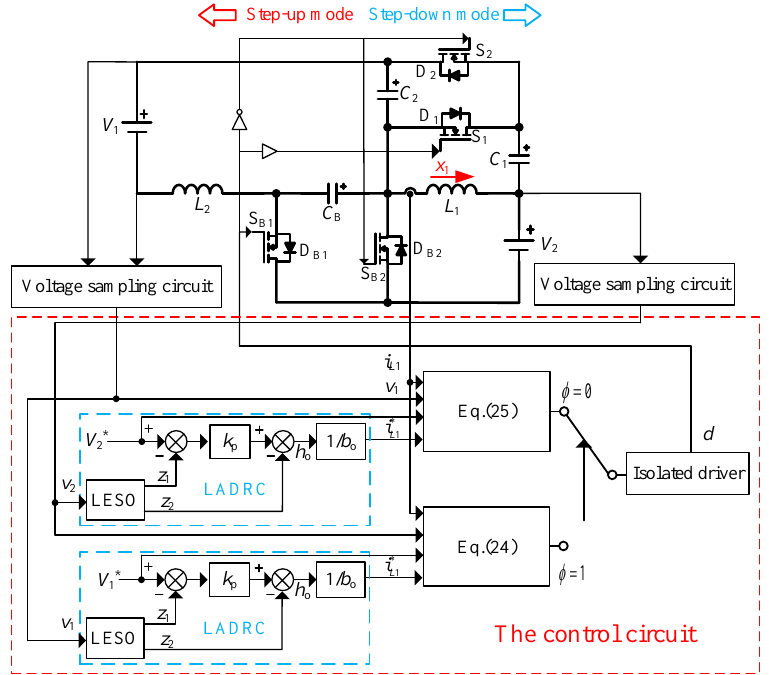
Figure 7. The passivity-based control with LADRC.